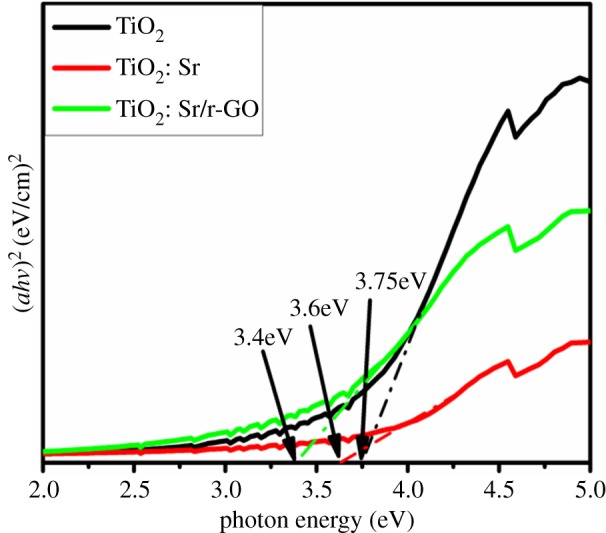
Band gap measurement by (αhν)2 Vs photon energy (hν) plot of as synthesized TiO2, TiO2: Sr, TiO2: Sr/r-GO.